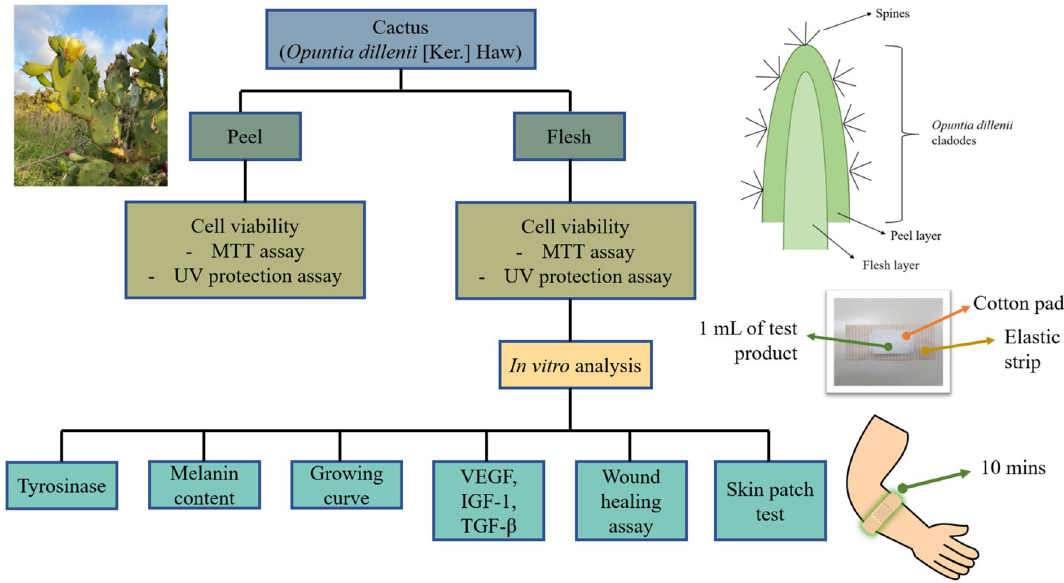
Figure 1. The experimental design of cactus extract (peel and flesh) on B16-F10 cell proliferation and tyrosinases inhibition